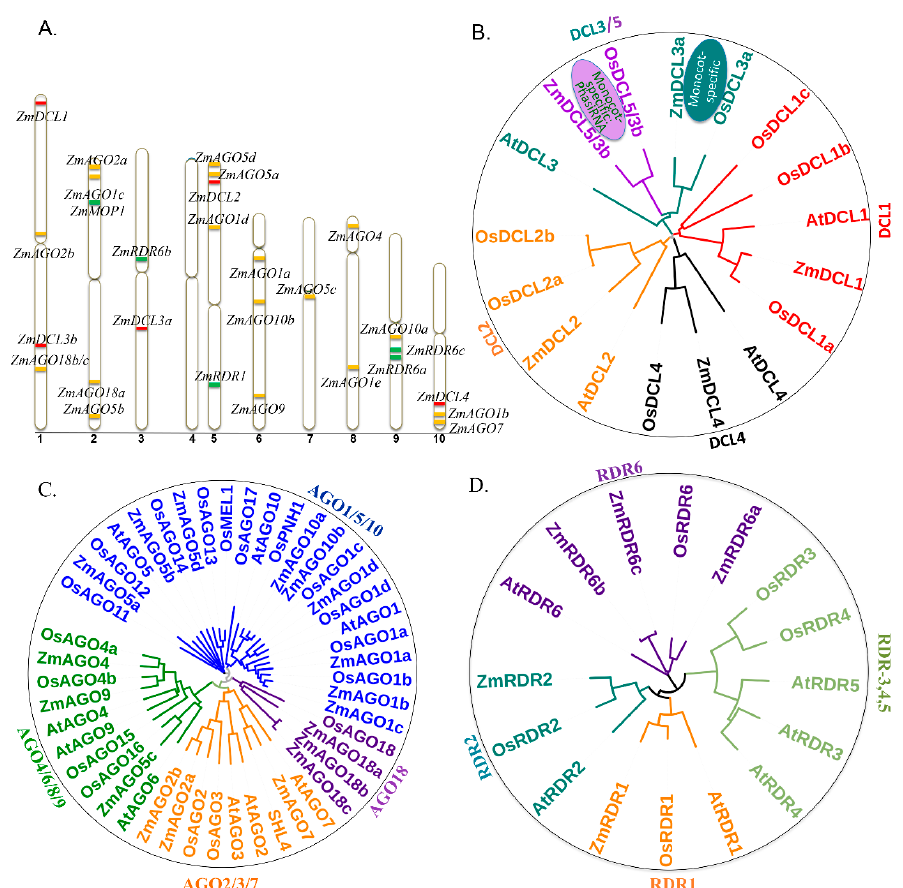
Figure 3. Chromosomal locations and phylogenetic analysis of known and putative components of the RNAi and miRNA pathways in maize. The protein sequences of dicer-like (DCL), argonautes (AGOs) and RNA-dependent RNA polymerase (RDR) in Arabidopsis , rice and maize AGOs were obtained from protein database (http://www.ncbi.nlm.nih.gov/protein). The neighbor-joining tree was constructed using Clustal omega [70] and iTol online software [71] . ( A ) The abbreviation of At represents Arabidopsis thaliana , Os for Oryza sativa , and Zm for Zea mays . Red bars indicate the chromosomal locations of ZmDCLs , yellow bars for ZmAGOs , and green bars for ZmRDRs . ( B ) Plants have four types of DCL proteins. There are 4 DCLs encoded in Arabidopsis genome, 4 DCL family members in rice, and 4 DCLs in maize. Of these DCL proteins, DCL3a and DCL3b are considered specific to monocots and predate the divergence of rice and maize. ( C ) 10, 19 and 18 AGOs are encoded by Arabidopsis , rice and maize, respectively, that can be divided phylogenetically into five subgroups in maize: AGO1, MEL1/AGO5, AGO7, AGO4, and AGO18. AGO18 subgroup has three members in maize. ZmAGO18a-c are considered specific to monocots along with OsAGO18. (D)